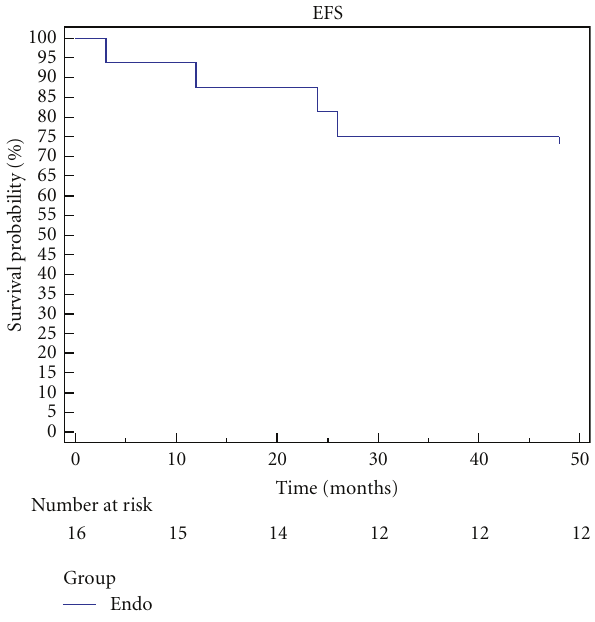
Figure 2: The Kaplan-Meier curve for event free survival (EFS). Patients lost to the follow-up were censored ( n =